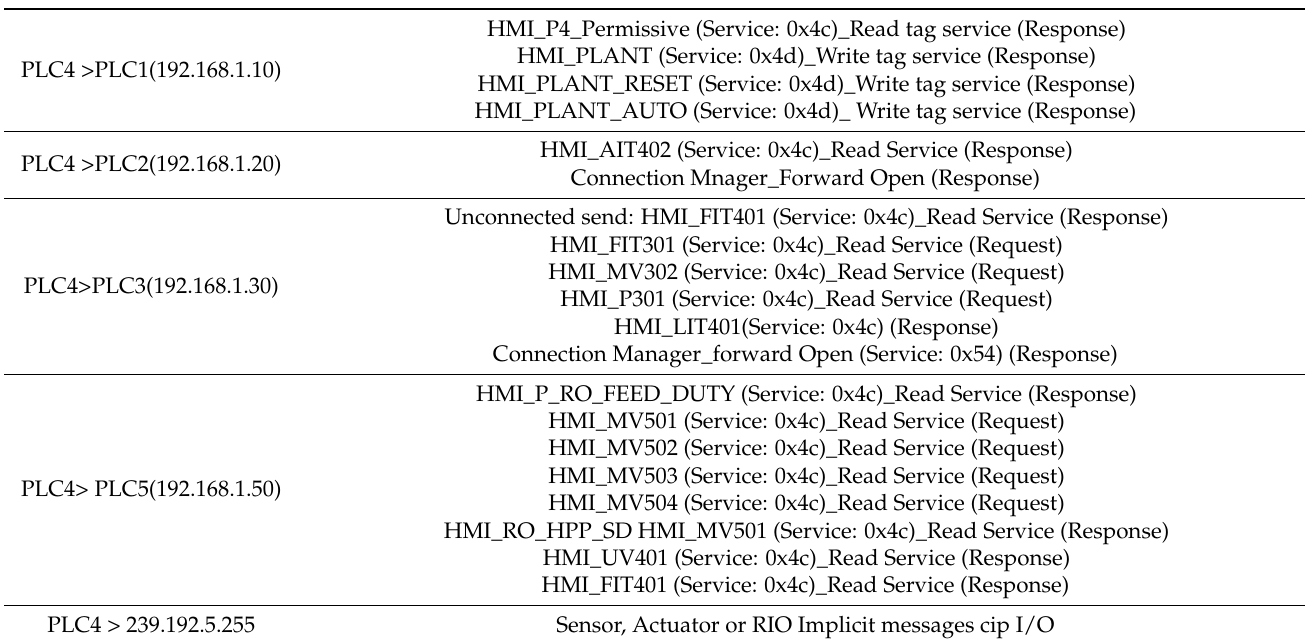
Table A4. PLC4 Communications in SWaT.